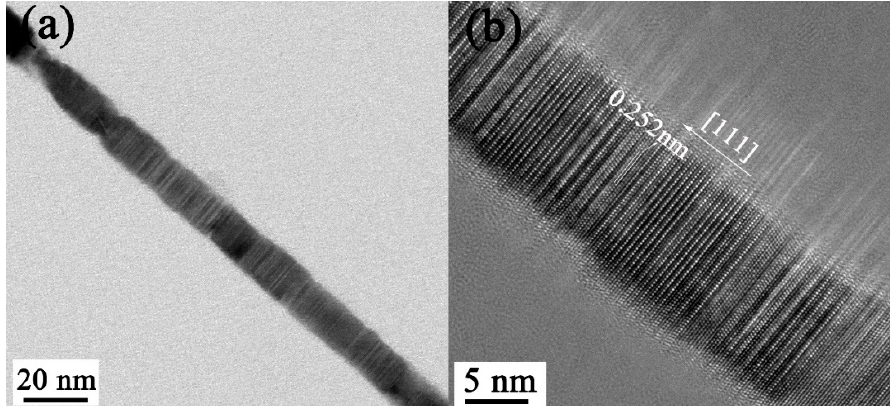
Figure 4. ( a ) Transmission electron microscopy (TEM) image of an individual CSed SiC NW and ( b ) Atomic TEM images taken from 4a.